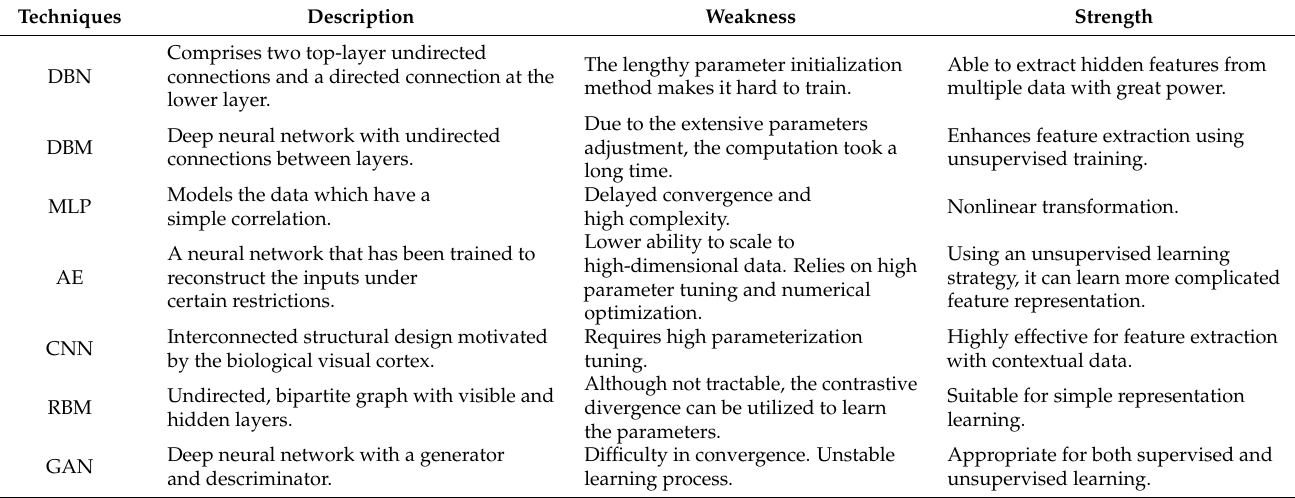
Table 1. Comparison of the deep learning